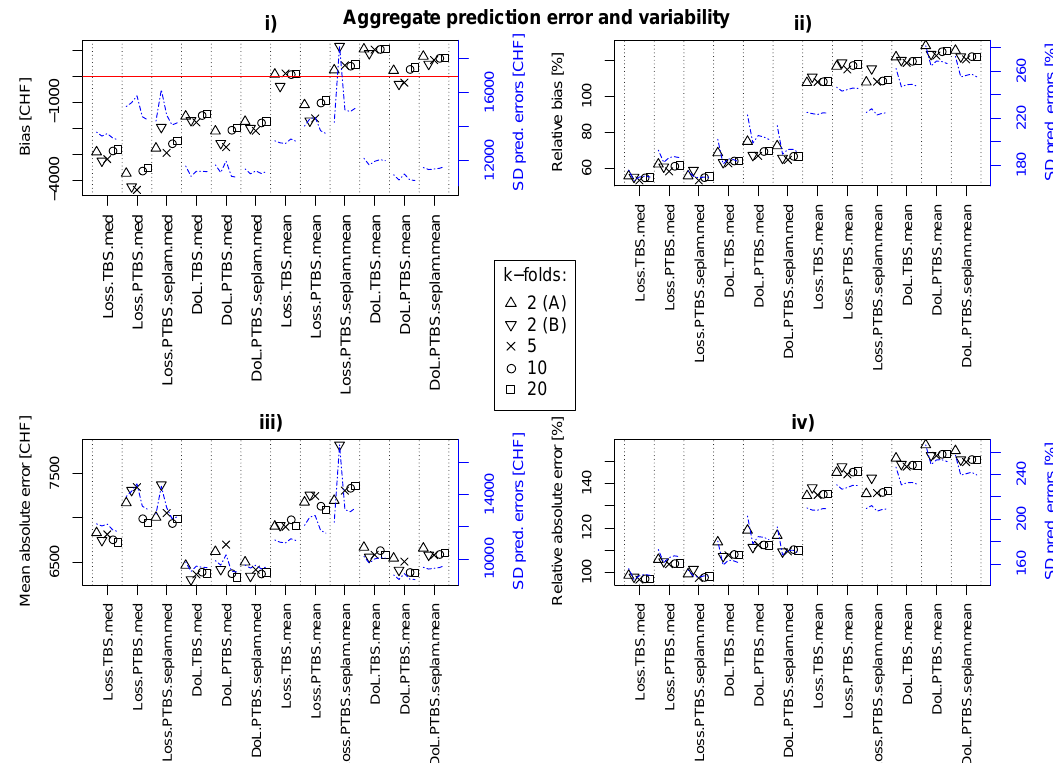
Figure A6. Non-random cross-validation. K -fold = 2, ( A ): Obwalden + Ticino vs. Schwyz + Valais + Uri; ( B ): Obwalden + Schwyz vs. Ticino + Valais + Uri. K -fold = 5: One group per canton. K -Fold = 10/20: Split Obwalden, Ticino, Schwyz and Uri into multiple groups such that all groups have approximately the same size.